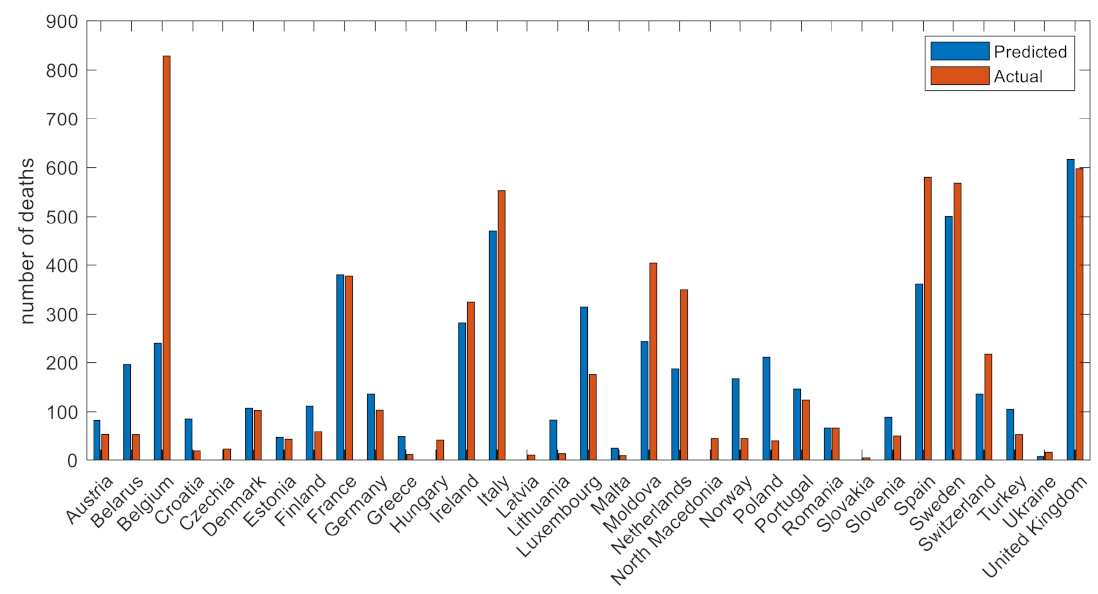
Figure 4. Actual versus predicted number of deaths in wave